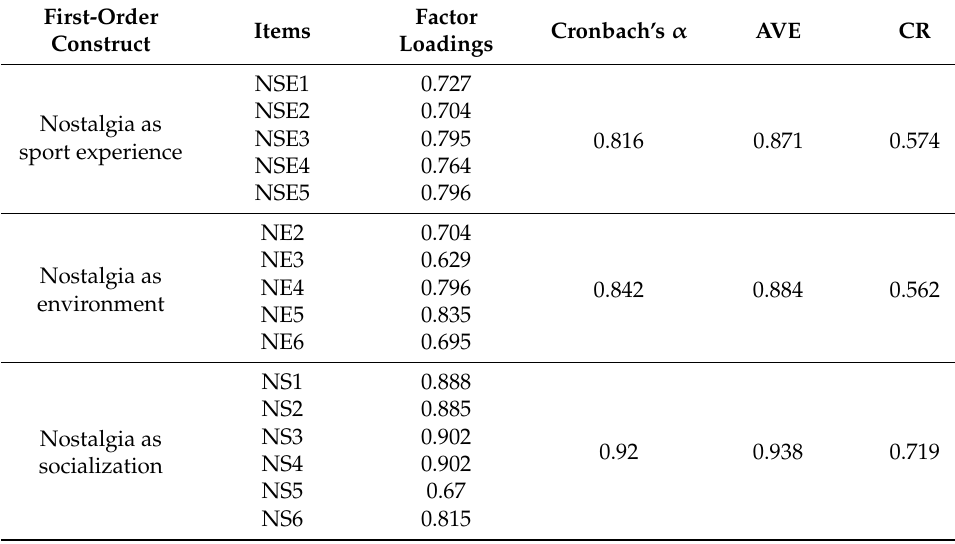
Table 1. Assessment of measurement model: first-order